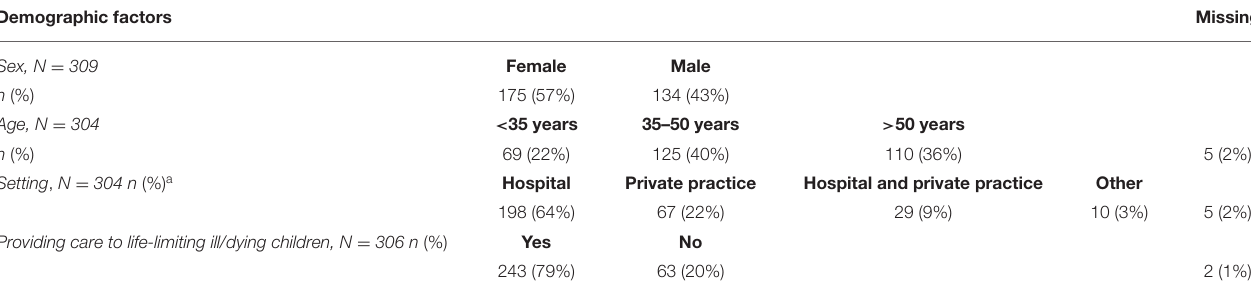
TABLE 1 | Pediatricians’ demographics ( N = 309). Demographic factors